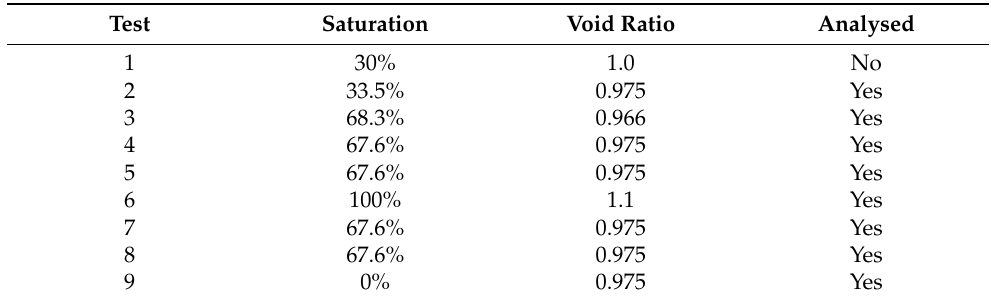
Table 2. Tests conducted for wetting front mobility using the ethyl benzoate/lamp oil mixture.